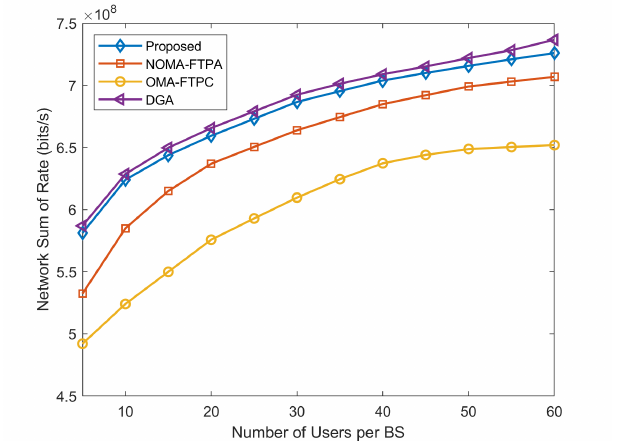
Figure 4. Network sum rate with different numbers of users per